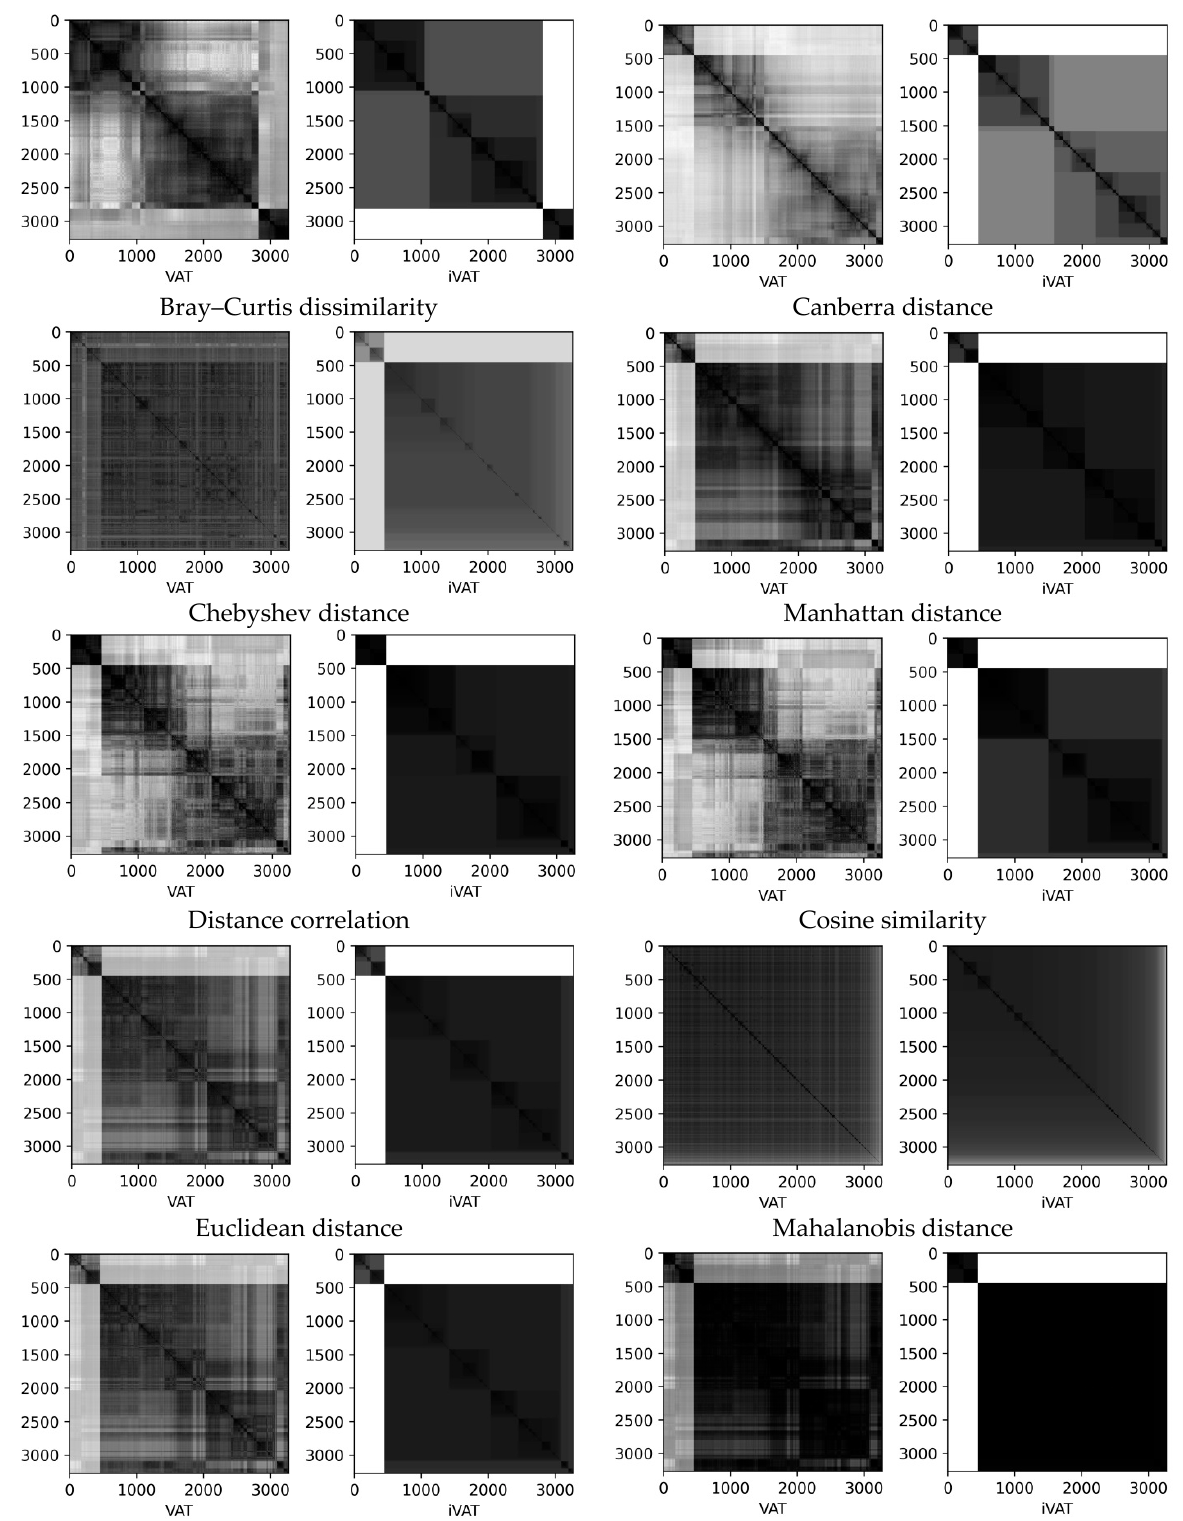
Figure A8. Chunsky forestry. Cluster heat map.